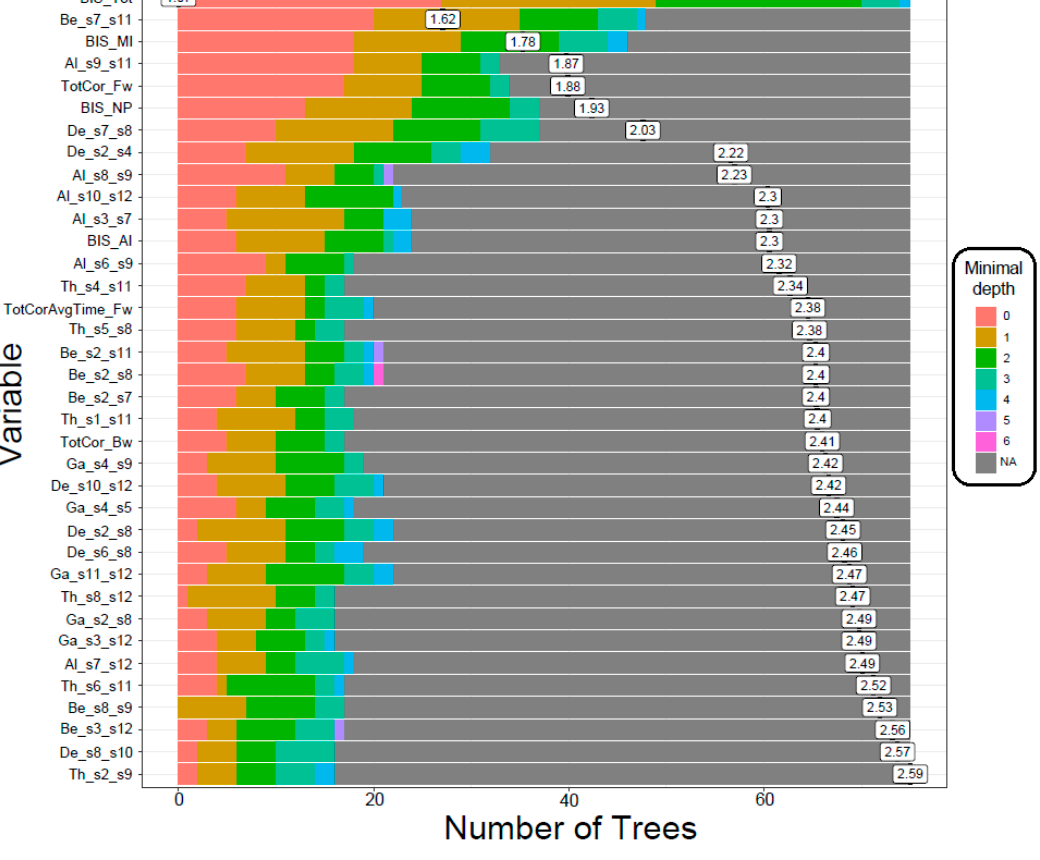
Figure 3. The distribution of minimal depth among the trees of the forest for the significant variables is shown in different colors for each level of minimal depth. The mean minimal depth in the distribution for each variable is marked by a vertical black bar overlapped by a value label inside a box. Lower mean minimal depth of a functional connectivity variable represents higher number of observations (participants) categorized in a specific group on the basis of the variable (i.e., better classification). The top significant variables (29 functional connectivity connections, 3 neuropsychological scores and all 4 impulsivity scores) followed the same rank in the plot as in Table 3, which is ordered based on p -values. [Abbreviations in the FC variable labels: De – Delta; Th – Theta; Al – Alpha; Be – Beta; Ga – Gamma; s1-s12 – default mode network (DMN) seeds 1-12 as listed in Table 2] .